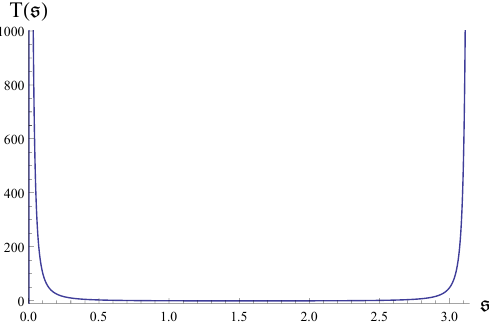
Figure 13. The numerical result for T ( s ) with δ = 5 ∗ 10 − 6 , see [108] for the code. We use the expression for the Schwarzian in [105]. The result corroborates the expectation (5.24) that the stress-energy in the near-quench region is positive and large. The result in the far-from-quench region is not trustworthy, because τ ≈ . 7 in this case and the relevant limit is τ → 0